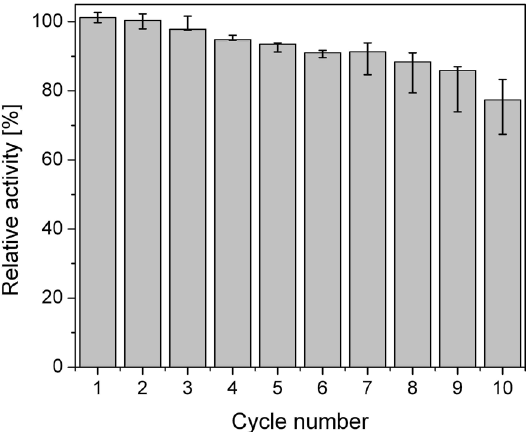
Figure 16. Recycling diagram of immobilized